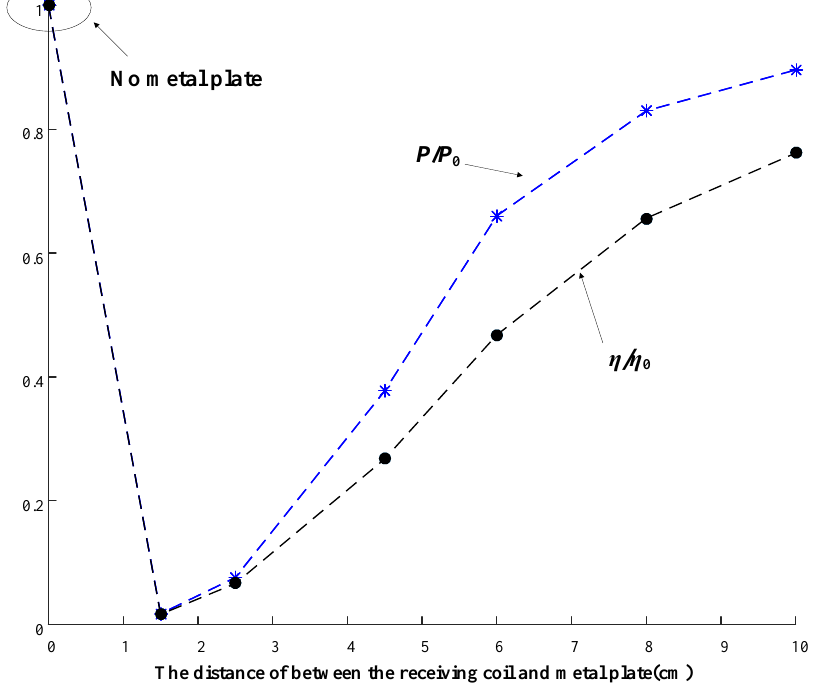
Figure 10. Effect of metal plate‘s distance on transferred power and PTE of systems.